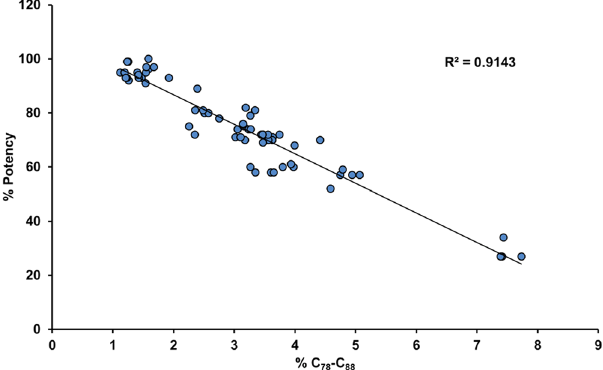
Figure 4. Correlation of incorrect disulfide bridge C 78 -C 88 and potency. The relative amount of C 78 -C 88 was quantified by non reducing peptide map analysis in different samples including reference product (Enbrel ® ), GP2015 (Erelzi ® ), process intermediates and late eluting HIC fractions. Evaluation of incorrect disulfide bridging relative to potency in these samples revealed a strong inverse correlation between potency and the relative abundance of C 78 -C 88